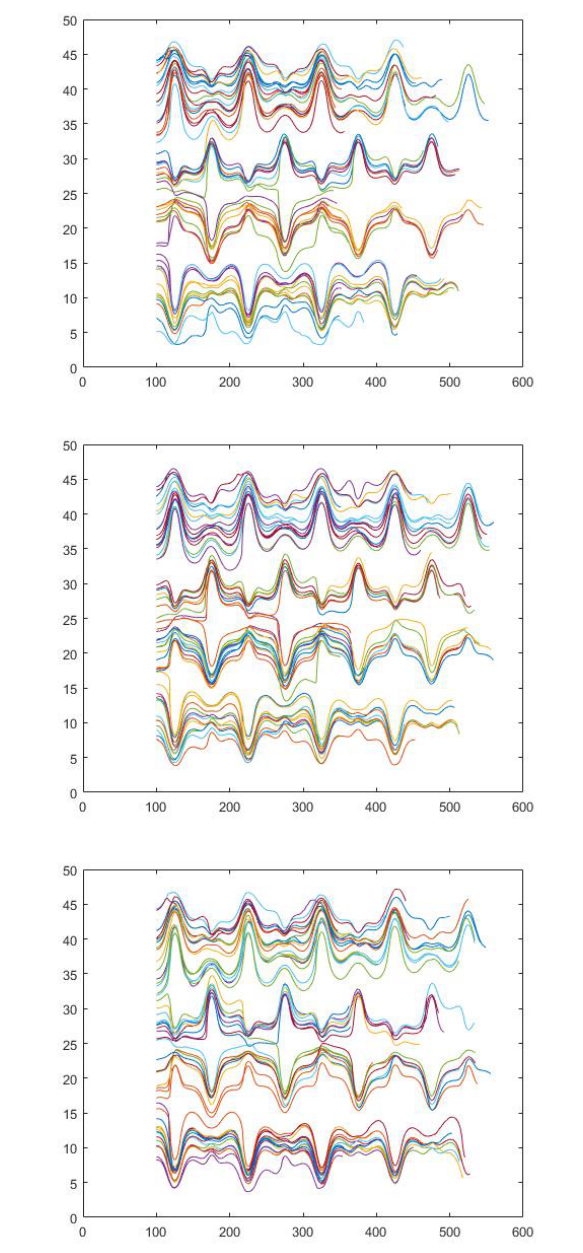
Fig. 17. Geometry A50, three different seedings, the Y- coordinate position in relation to X-coordinate. Values are shifted in the X-direction, to obtain the same starting position for all the cells.